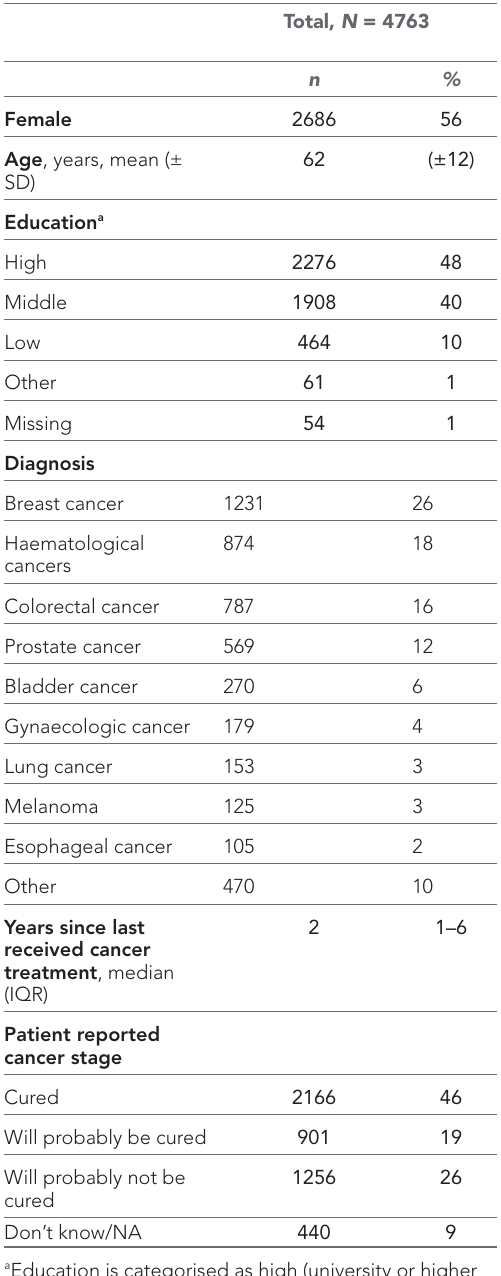
Table 1 Baseline characteristics of